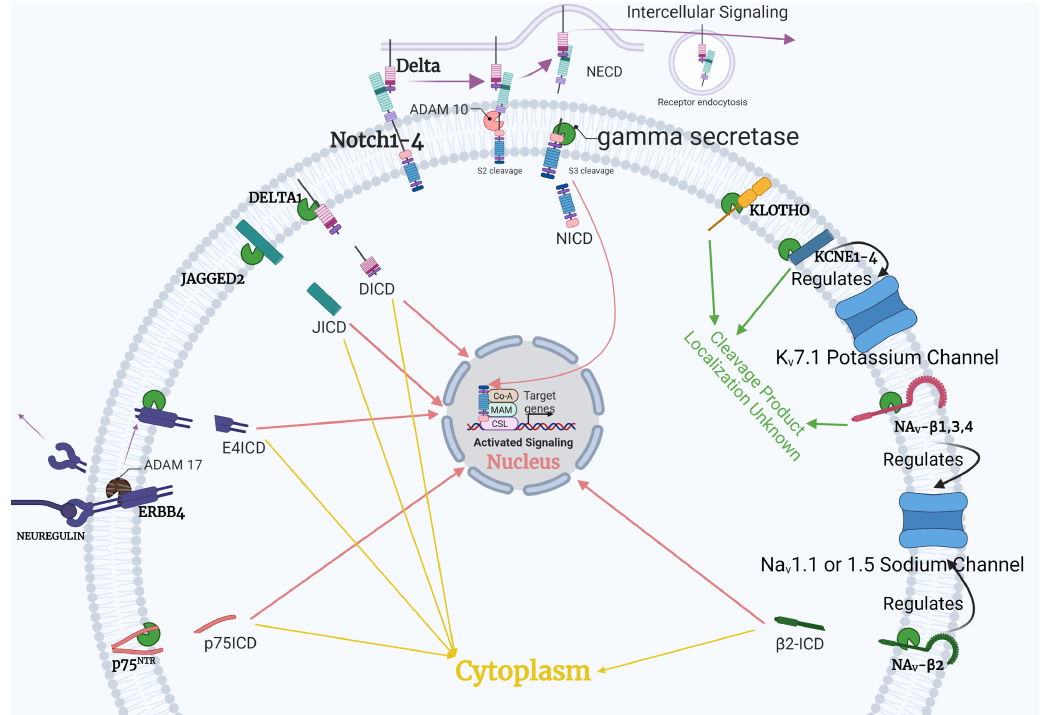
Figure 2. Processing of the cardiac-relevant substrates by gamma-secretase activity. The cell-type specific findings can be referred to Table 2. The in-depth explanation of Notch signaling serves as an example for the generalized gamma-secretase function. The red and yellow arrows show where intracellular domains (ICDs) from cleaved products localize in the cell. Products with unknown localization are labeled with green